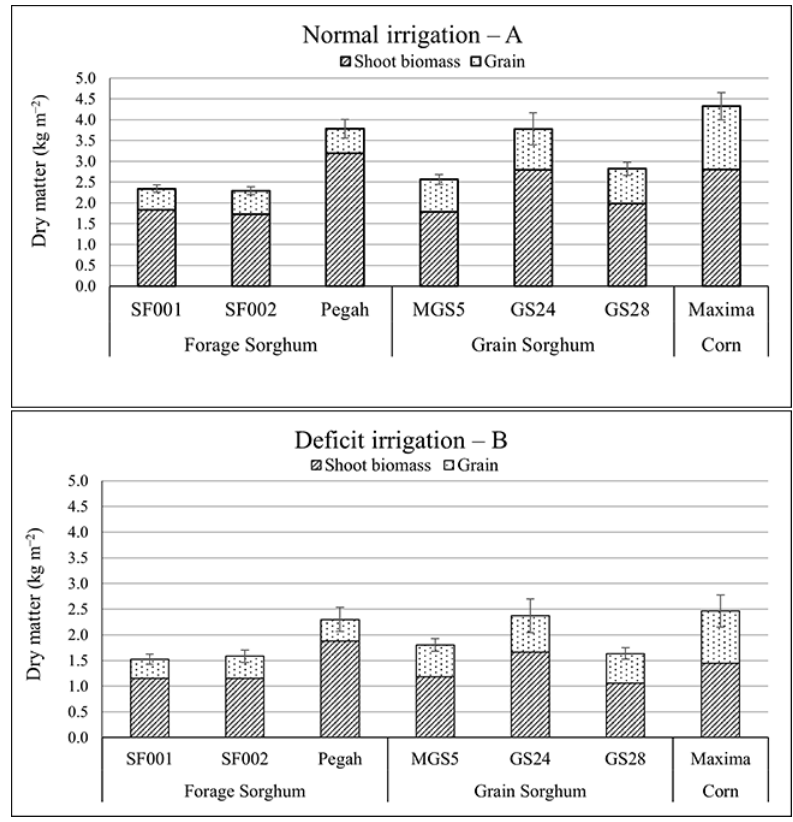
Figure 1 Effects of normal ( A ) and deficit irrigation ( B ) regimes on shoot biomass and grain yields in corn as well as grain and forage sorghum genotypes. Error bars are related to the amount of total dry matter yield (grain + shoot